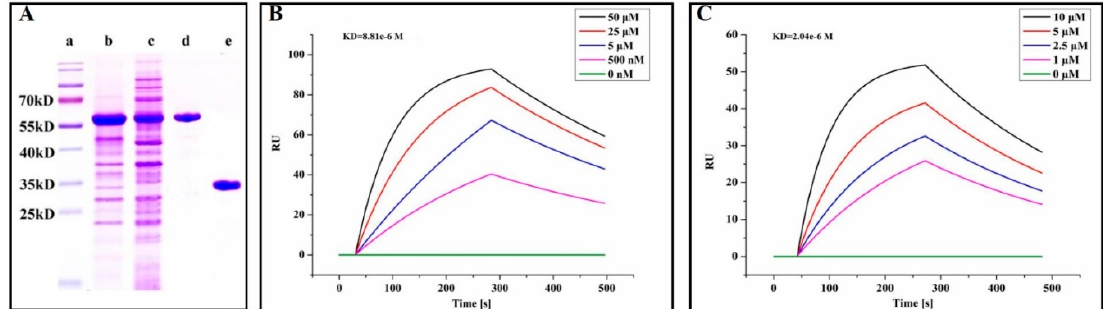
Figure 7. Analysis of the interaction between PEDV 3CL pro and quercetin by surface plasmon resonance (SPR) assay. ( A ) Expression and purification of PEDV 3CL pro . Lane a, protein marker; lane b, inclusion body proteins; lane c, supernatant proteins; lane d, purified GST-tag PEDV 3CL pro ; lane e, purified PEDV 3CL pro . ( B ) The binding curve of quercetin with 3CL pro in the surface plasmon resonance (SPR) assay. ( C ) The binding curve of GC376 with 3CL pro in the SPR assay.